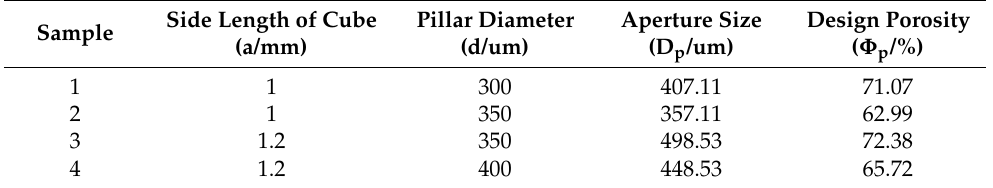
Table 2. Design parameters of regular octahedral porous structure.